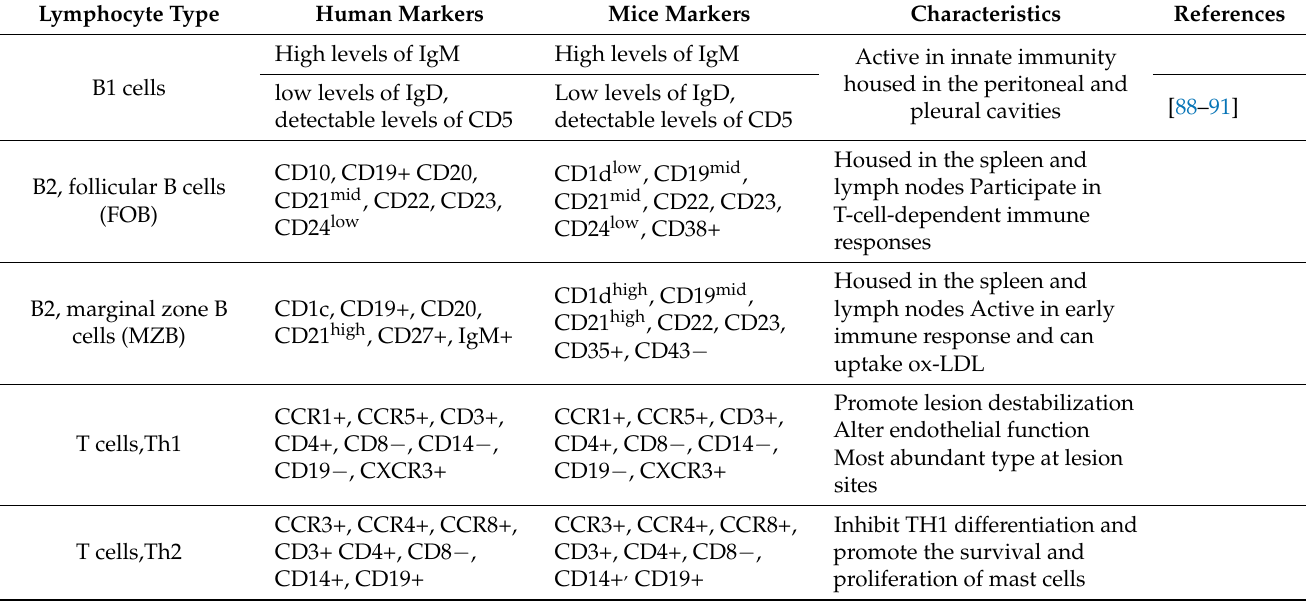
Table 3. Lymphocyte types and